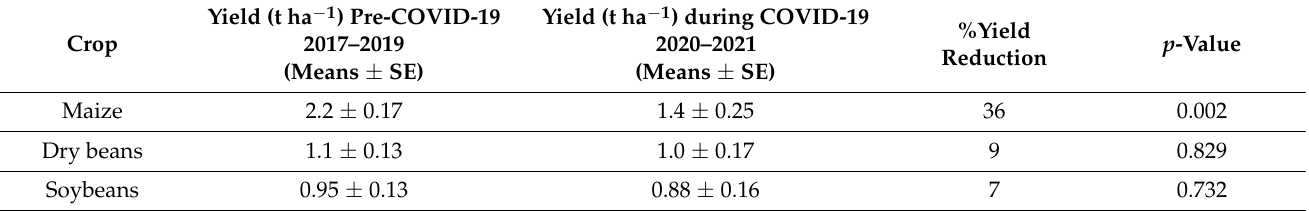
Table 2. Average yields trends of maize, dry beans, and soybeans during pre-COVID and COVID periods.